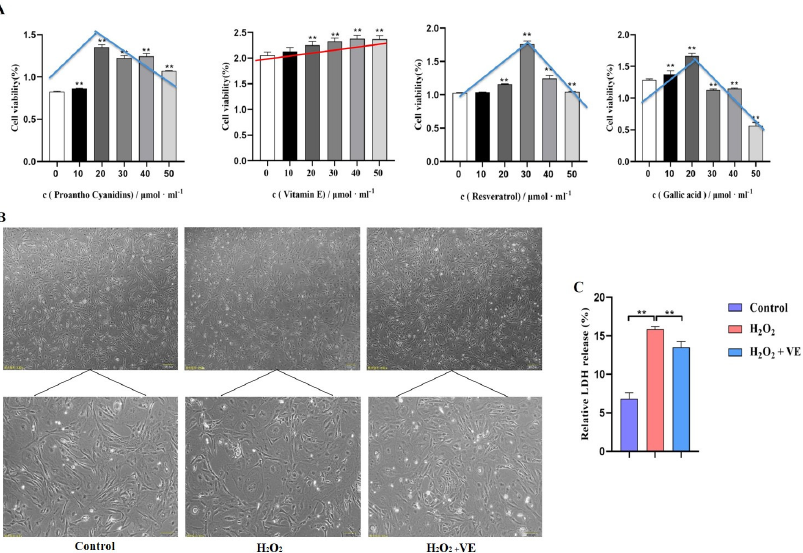
Figure 11. Role of antioxidants in GCs. ( A ) The effects of different antioxidants on the viability of GCs were determined by CCK − 8 assay; red/blue lines show the cell viability variation trend with different antioxidants. ( B ) Cell morphology and the state of goose GCs treated with VE under H 2 O 2 − induced oxidative stress conditions. ( C ) The effect of VE on alleviating H 2 O 2 − induced oxidative stress injury of GC membranes was explored by LDH release assay. The data represent the means ± standard errors of 3 independent experiments (** p < 0.01).